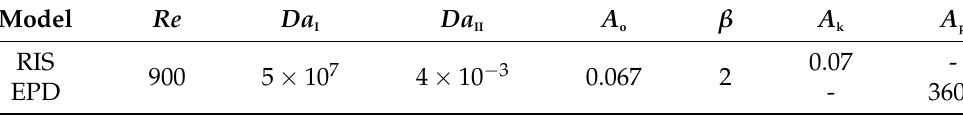
Table 3. The fixed parameters of all the